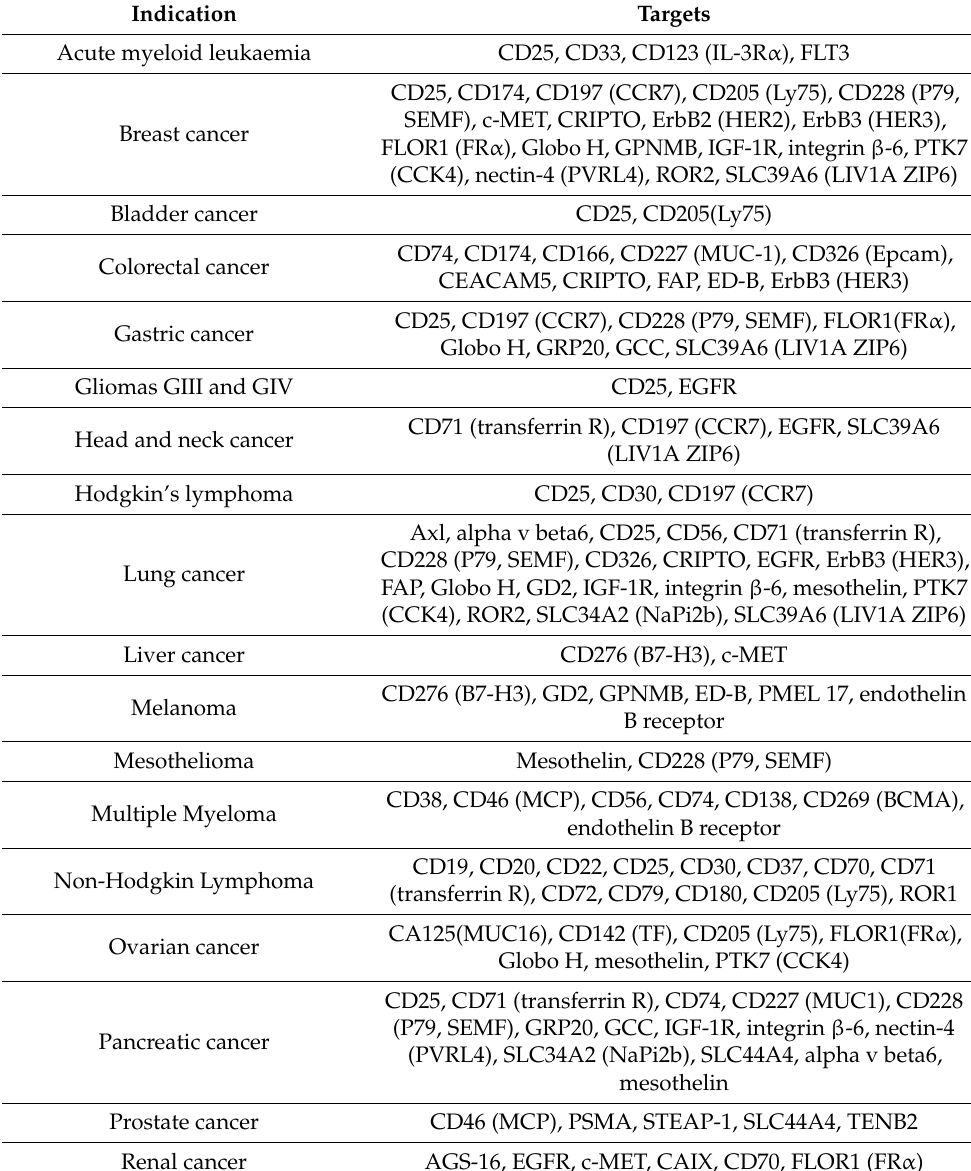
Table 1. Target antigens for ADCs under development or in the clinic for cancer therapy